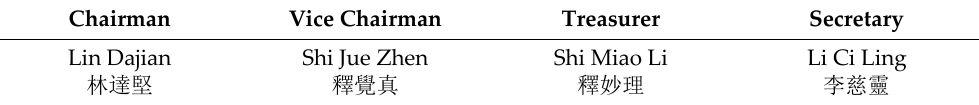
Table 1. The first management committee.